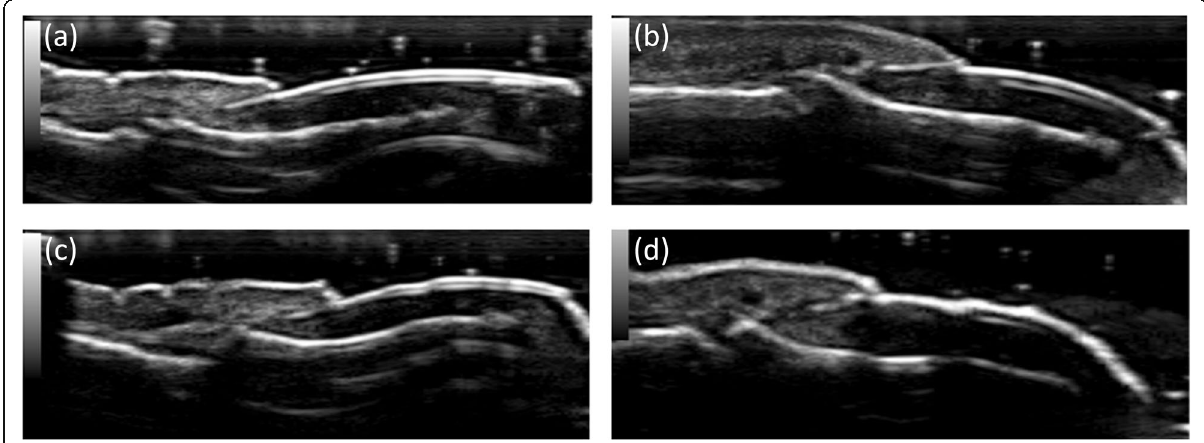
Fig. 1 Wortsman ’ s classification of psoriatic nail changes in the trilaminar structure of nail plate. Legend: (a) hyperechoic deposits in ventral plate; (b) lost of definition of the ventral plate, (c) wavy plates, (d) loss of definition of both plates. Authors ’